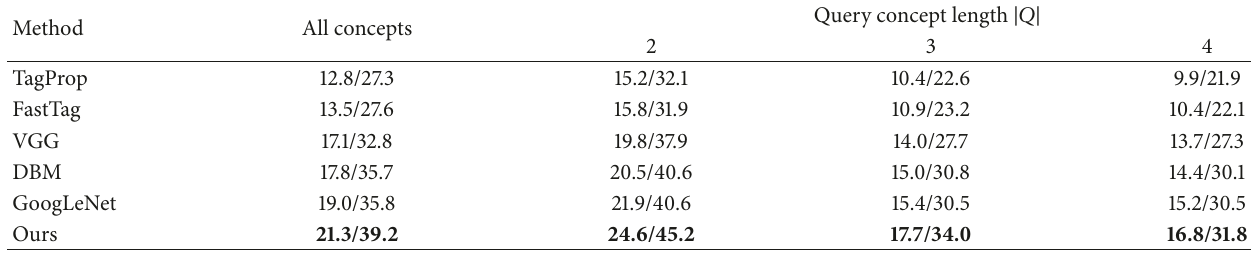
Table 1: MAPs (%) and P@10s (%) of semantic image retrieval over all 1599 semantic queries on MIR Flickr 2011. MAP scores and P@10 scores are given in the format MAP/P@10.